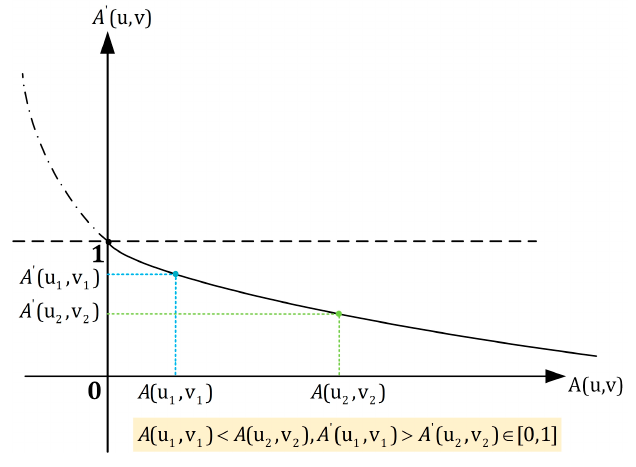
Figure 2. Schematic diagram of amplitude transformation.